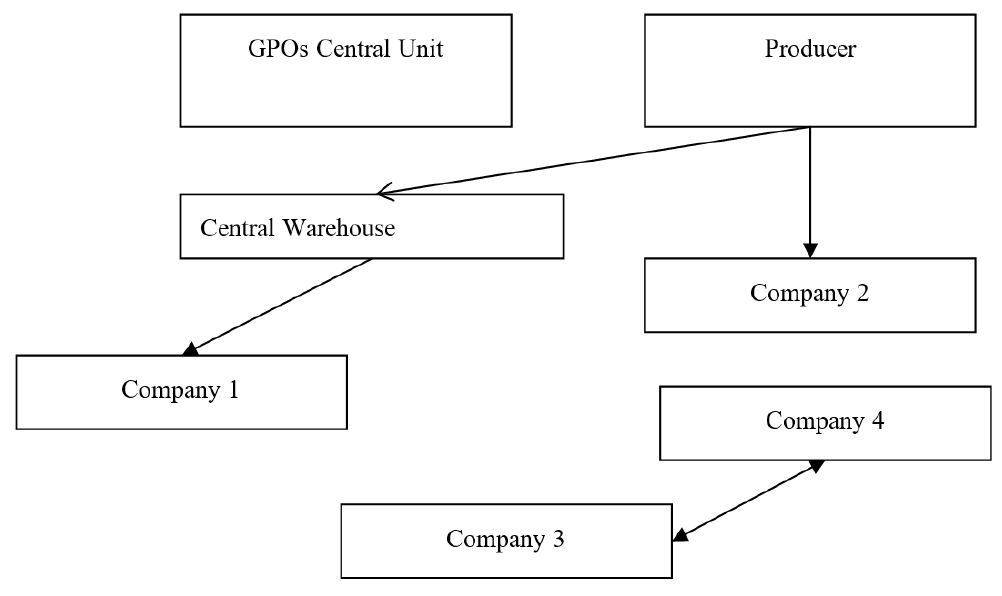
Figure 4. Model of operation of an industry purchasing group operating in the sector related to the renewable energy.